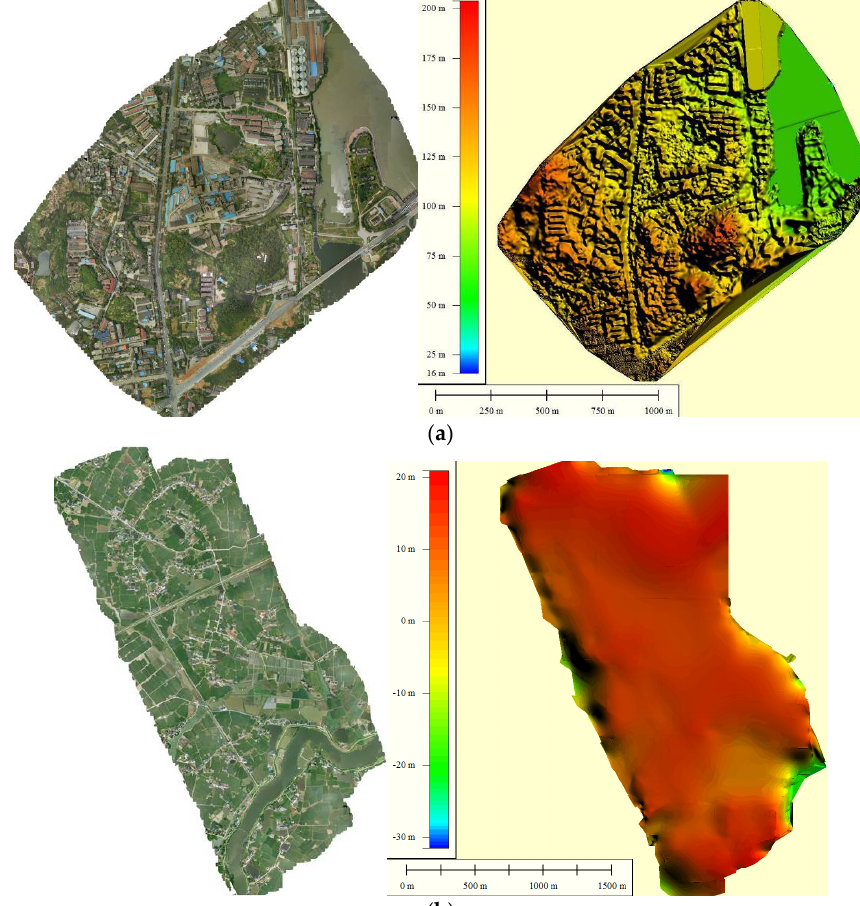
Figure 4. Cont. Figure 4. Cont.